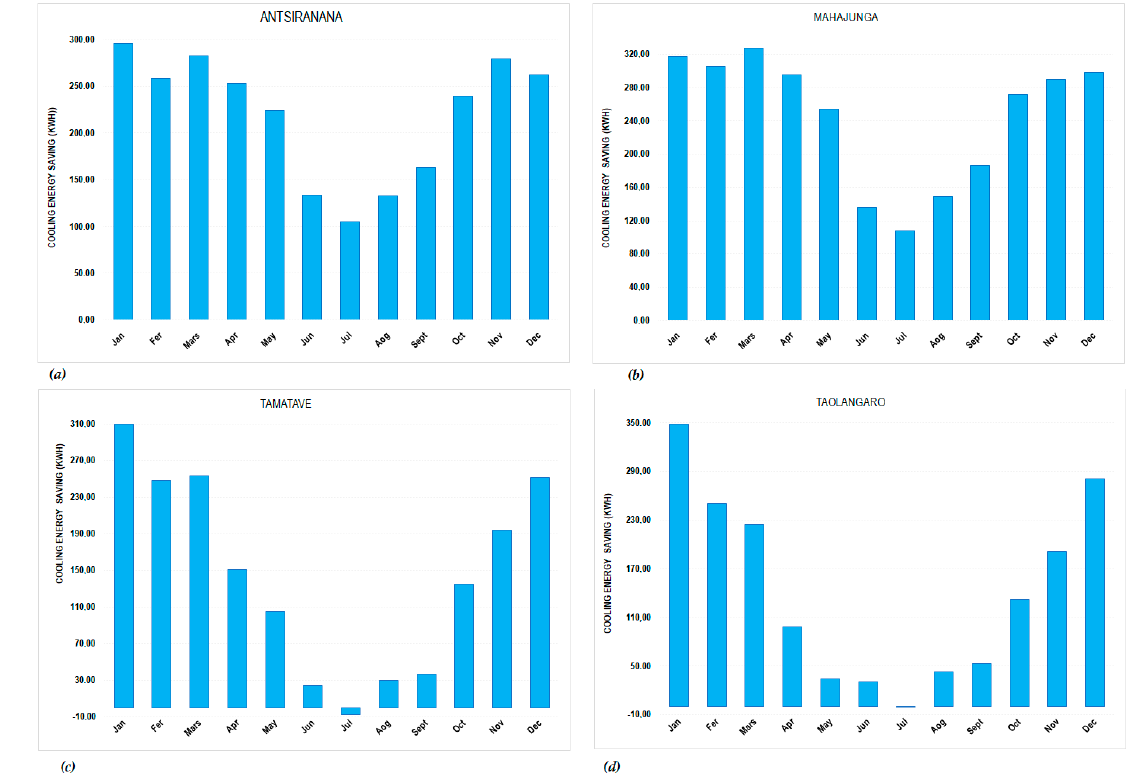
Figure 6. Cooling energy saving in the four cities during the two seasons.